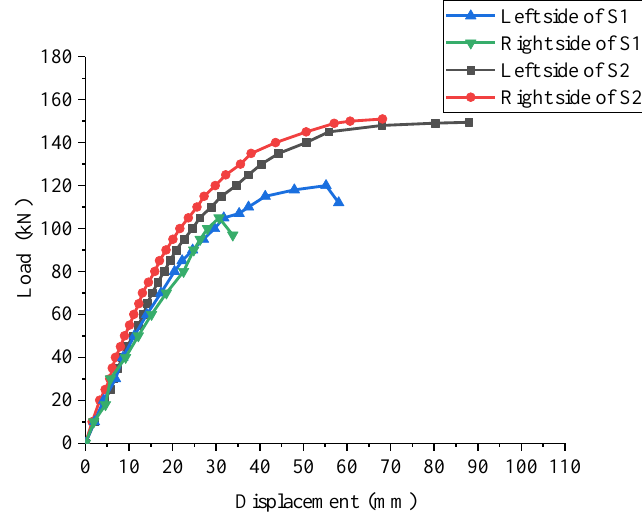
Figure 16. Load–displacement curve.